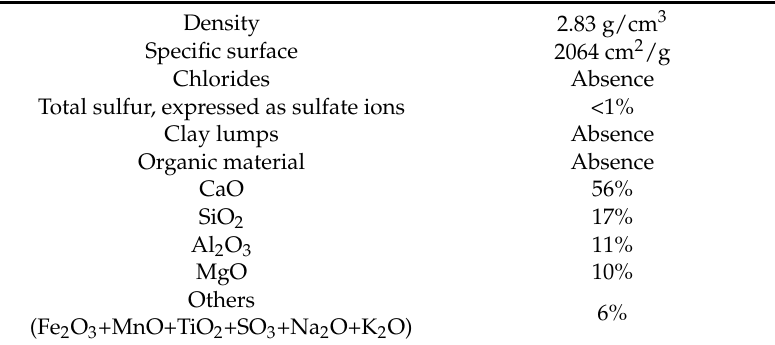
Table 3. Physical properties and chemical composition of ladle furnace slag (LFS).